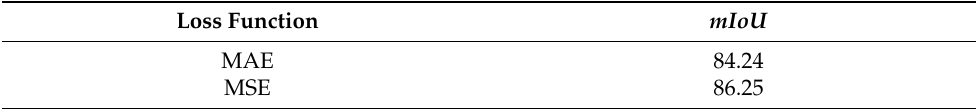
Figure 8. Results of pseudo-labels at different losses: ( a ) image; (b) ground truth; ( c ) reliable label; ( d ) modified CAM; ( e ) pseudo-label with MAE; and ( f ) pseudo-label with MSE. Note that the pseudo- label with MSE was better than the pseudo-label with MAE. Table 4. mIoU (%) of the pseudo-labels with different loss